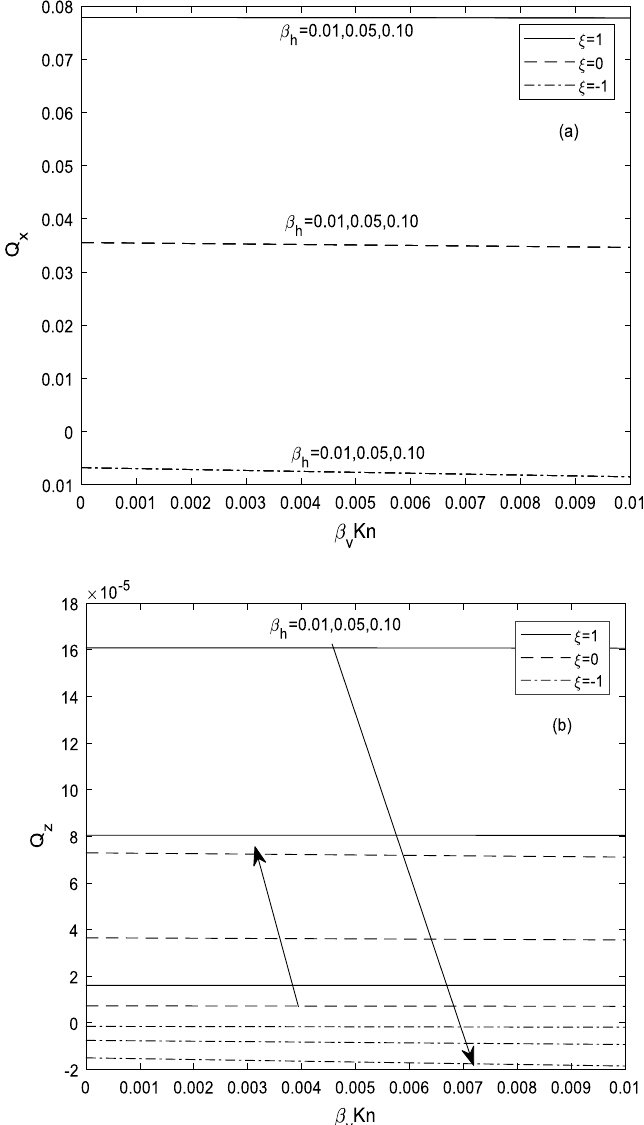
Fig. 16 a Hall current parameter ( β h ) on the main flow and induced volume flow rate for β v Kn = 0.05, S = 0.5, M = 2,ln = 1.667, β i = 3.0 and Pr = 0.71 . b Hall current parameter ( β h ) on the main flow and induced volume flow rate for β v Kn = 0.05, S = 0.5, M = 2,ln = 1.667, β i = 3.0 and Pr =